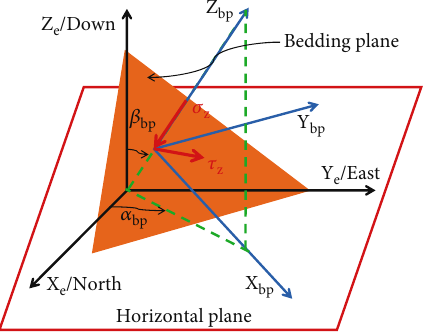
Figure 5: Reference coordinate systems of BPCS and GCS [1].